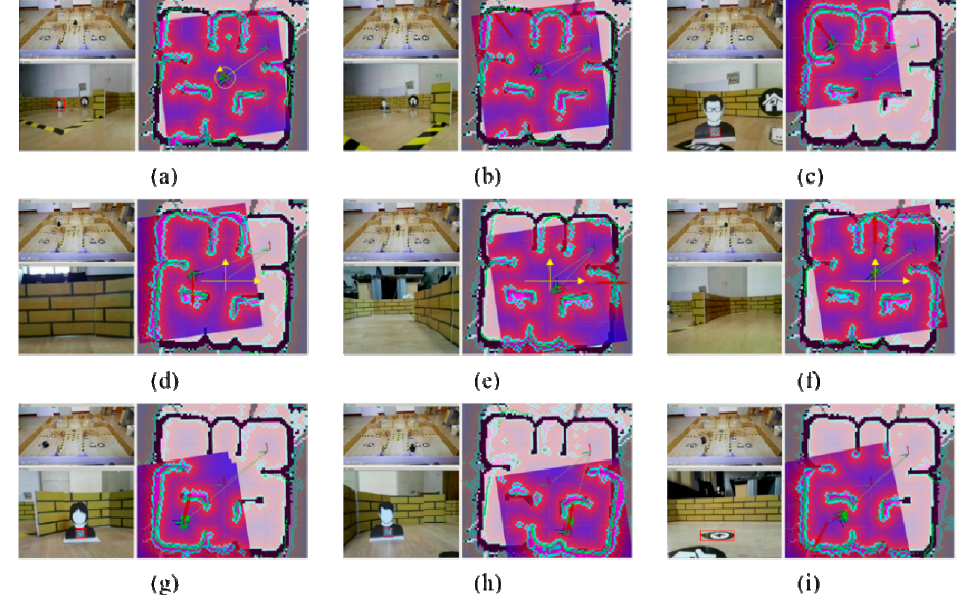
Figure 18. A sequence of snapshots for the real execution of the atomic action sequence decomposed from the rescue task. ( a ) The circle strategy to search the target object; ( b – d ) Find the target victim recognize and rescue the victim; ( e , f ) The cross-search strategy to find the other target victims; ( g – i ) Rescue the remain two victims and